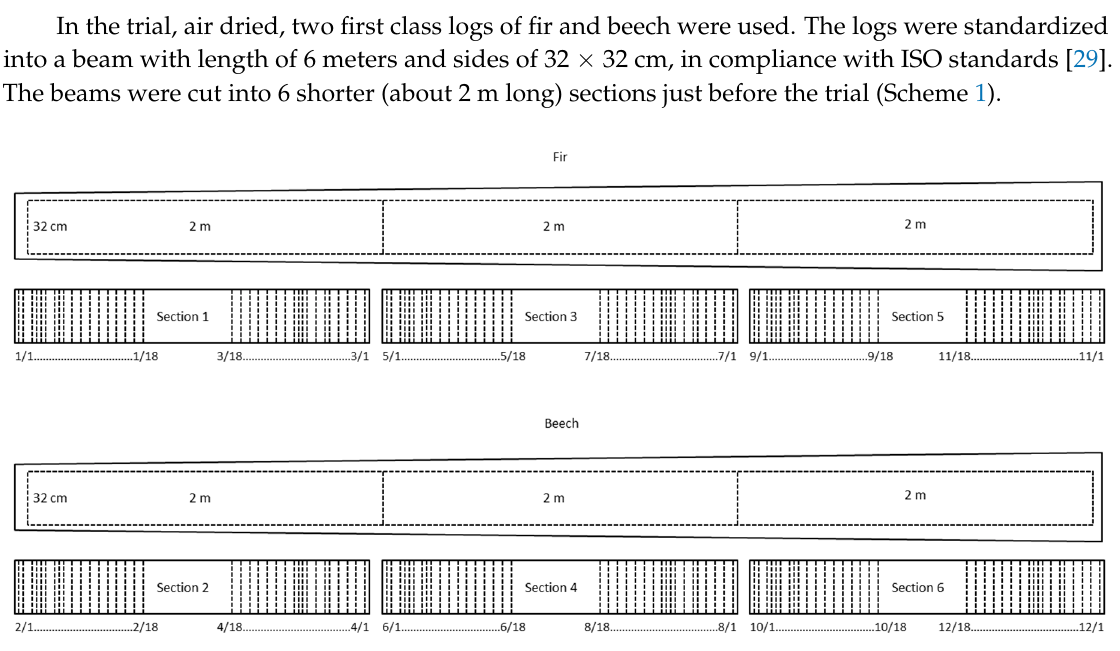
Scheme 1. Preparation and division of wood beams from two trees species into sections and cross cutting sequence. Note: 1/1-cross-cut/chain setup sequence.